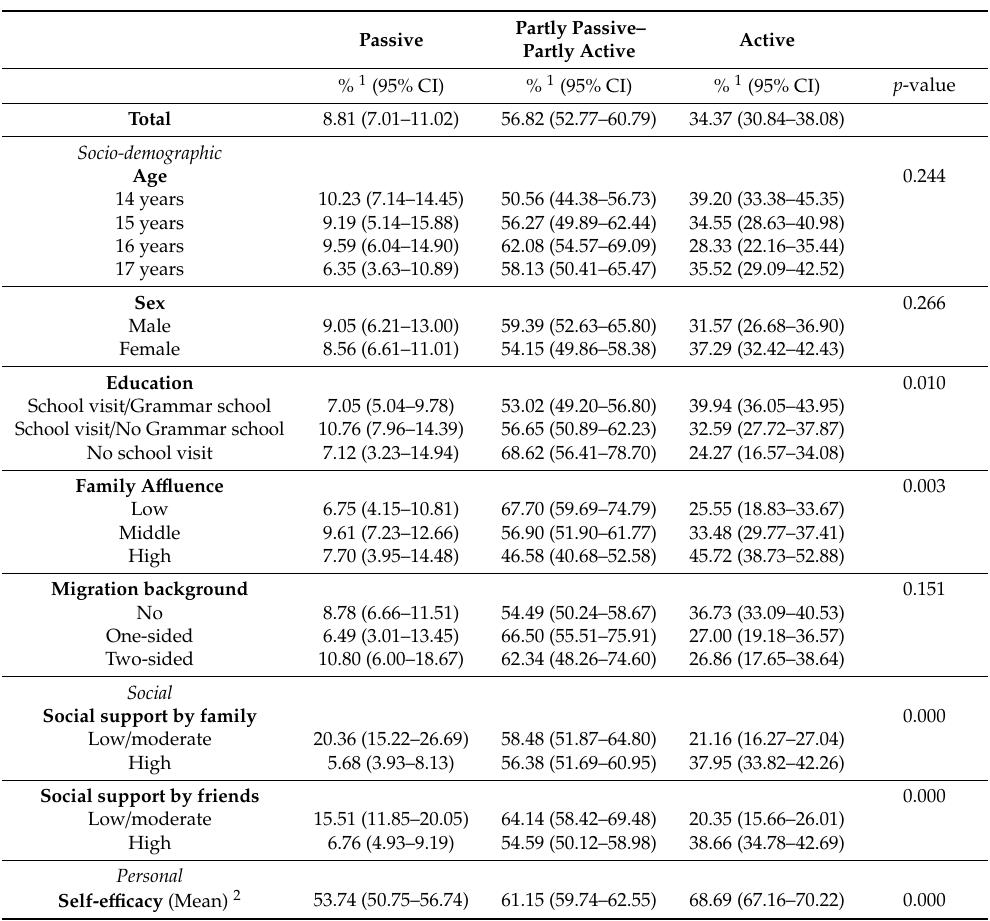
Table 5. Scale C: Weighted percentages and bivariate associations of attitudes toward one’s own health and health information and considered factors among adolescents aged 14–17 ( n = 1202) based on GeKoJu 2019